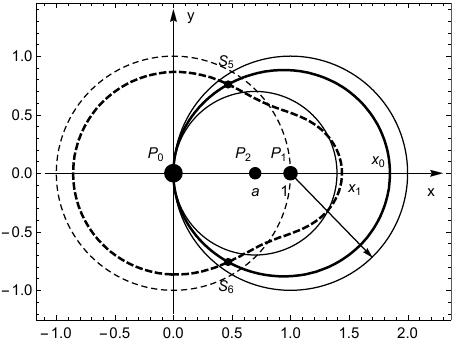
Figure 3. Triangular equilibrium positions S 5 and S 6 , µ 1 = 0 . 1, µ 2 = 0 . 04, 0 < a <